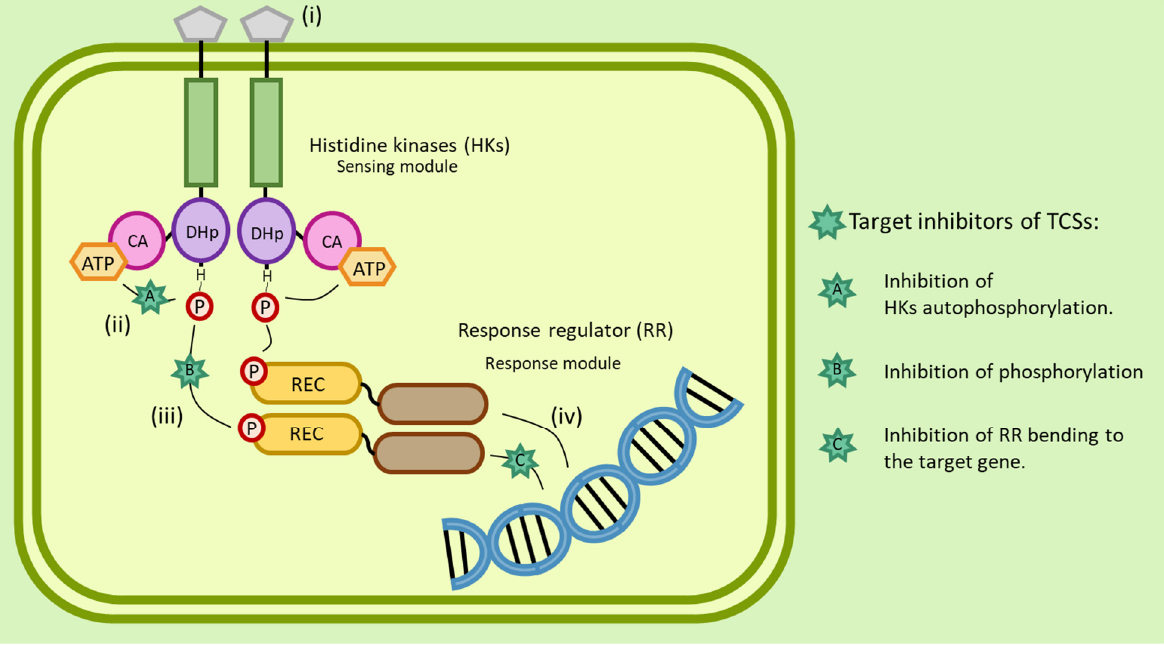
Figure 3. Overview of the bacterial TCS system and targets of inhibitors against TCS components. Signal transduction by TCS is initiated by stimulation of the sensing domain: (i) the CA domain binds with APT, and the HKs in the DHp domain are autophosphorylated; (ii) subsequently, the phosphoryl group is transferred to the Aps residue in the RR; (iii) a reaction that regulates the ex- pression of target genes is activated; (iv) TCSs can control the gene expression of many important processes in